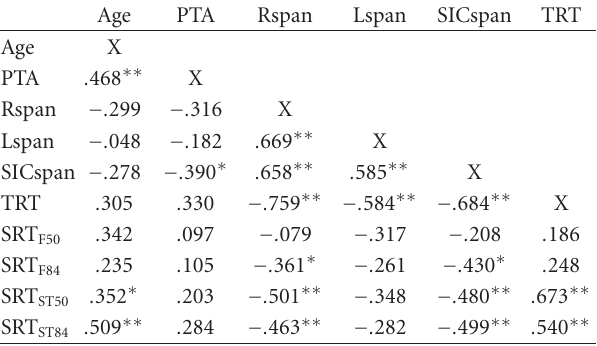
Table 2: Two-tailed Pearson correlations ( ∗ P < . 05, ∗∗ P < . 01) between age, PTA, Rspan, Lspan, SICspan, TRT, SRT with fluctuat- ing noise at 50% (SRT F50 ) and 84% (SRT F84 ) intelligibility, and SRT with a single-talker masker at 50% (SRT ST50 ) and 84% (SRT ST84 ) intelligibility. Lower TRTs and SRTs indicate better performance.